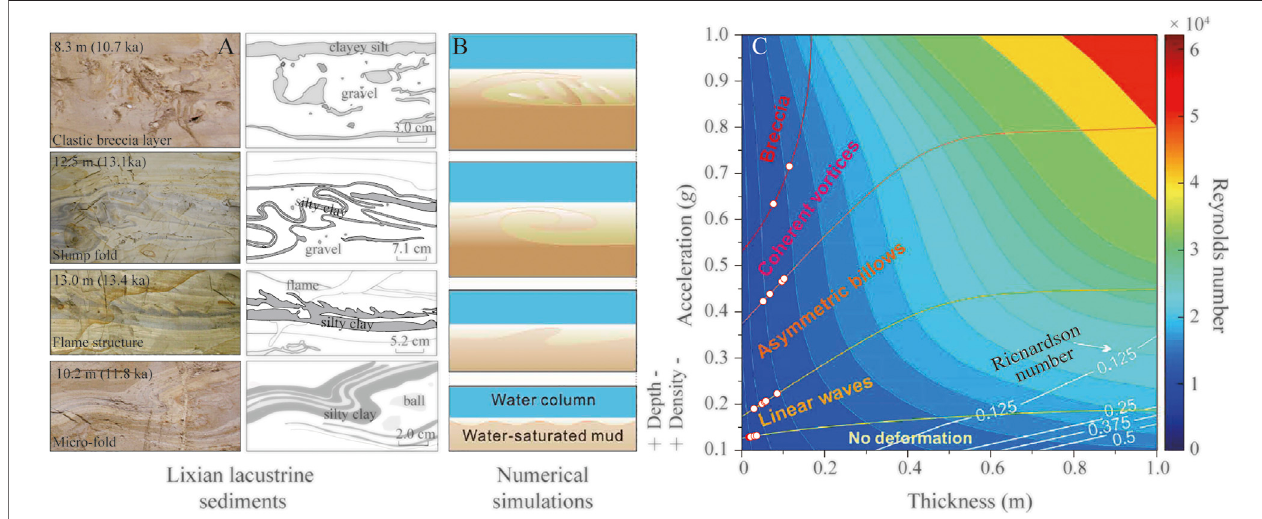
FIGURE2| SSDstructuresintheLixianlacustrinesequenceand thenumericalsimulation (A) Typicalstructures fromtheLixiansectionoutcrops (jiangetal.,2016) (B) Schematic diagrams of the four structures from the numerical simulations (Lu et al., 2020) (C) Quantitative estimation of the accelerations that are needed to initiate the four structures with different thicknesses (Lu et al., 2020). The circle represents different thickness and types of SSD in the Lixian section.